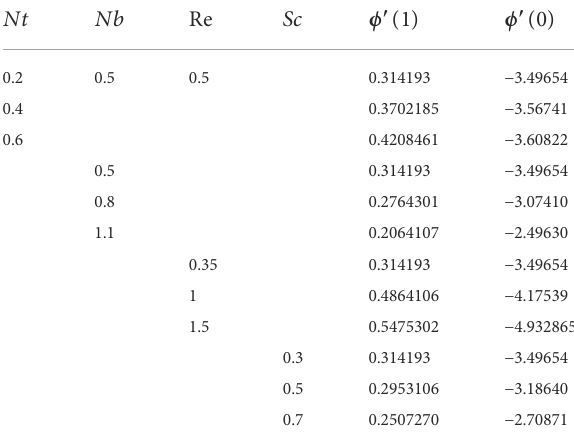
TABLE 4 Sherwood number Sh variation for different values of Nb and